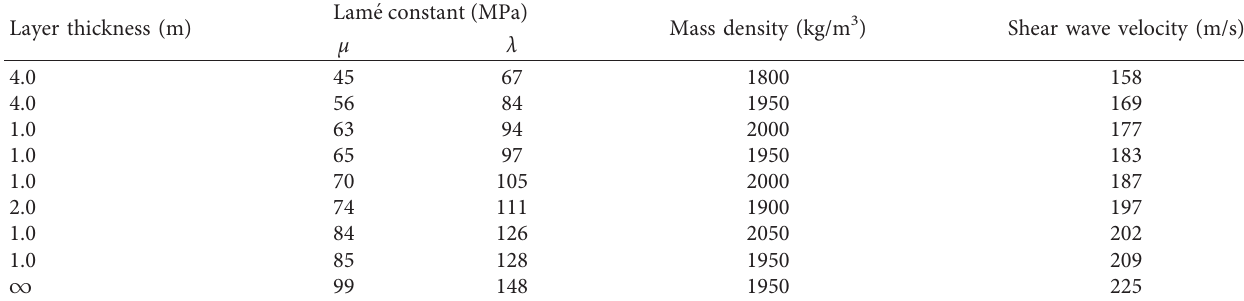
Table 2: Soil parameters.